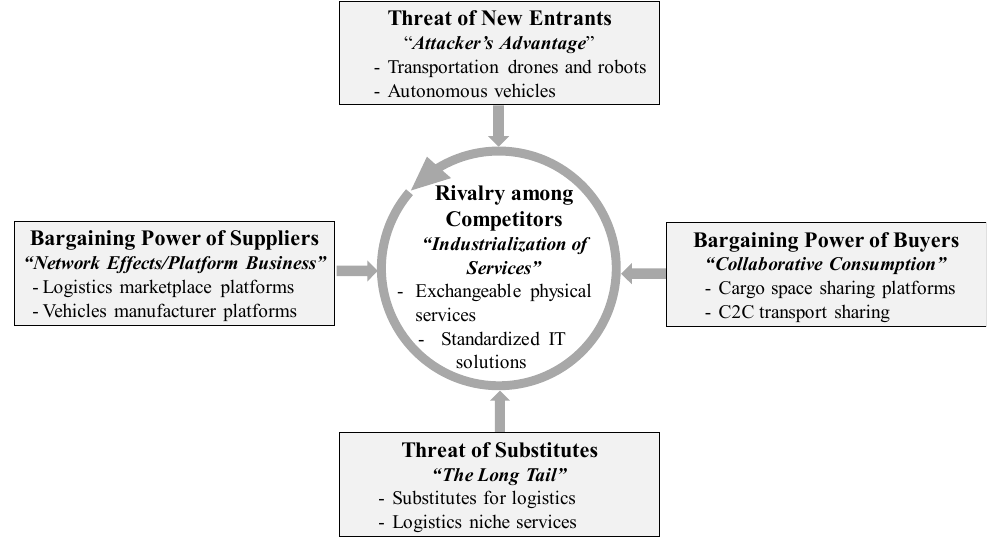
Figure 4. Screening of the logistics service industry in the new digital age. The identified force-theory combinations build up a new competitive arena for 3PLs, as logistics service providers are under pressure from all “sides” of the framework.